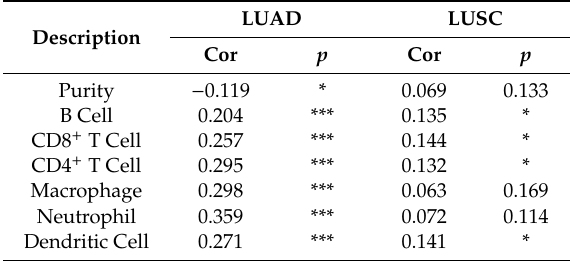
Table 1. Analysis of correlation between ATP / GTP binding protein 1 ( AGTPBP1) expression and immune infiltration in non-small cell lung carcinoma (NSCLC).